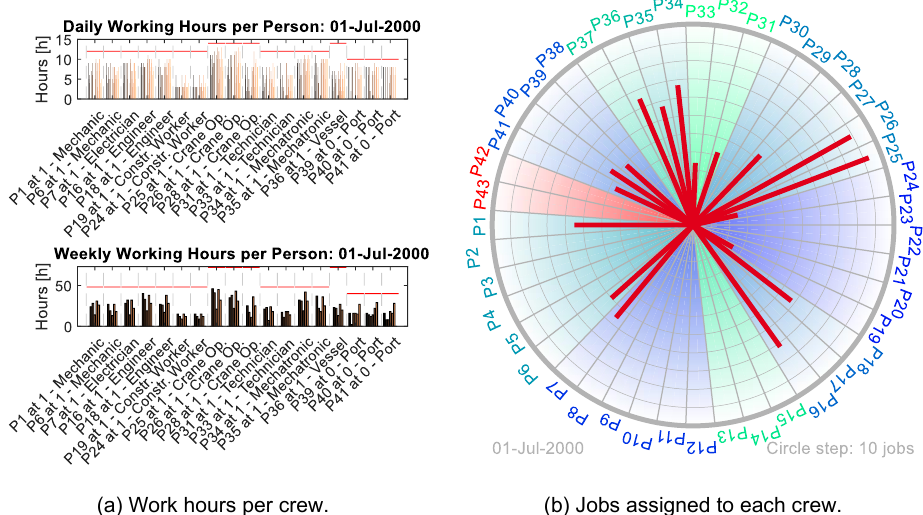
Figure 6. Exemplary results for the scenario July 2000 with one vessel and extended crew.